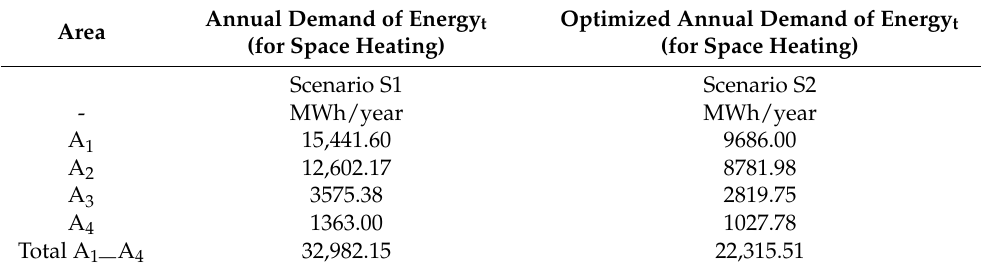
Table 6. Heat demands for areas A 1 –A